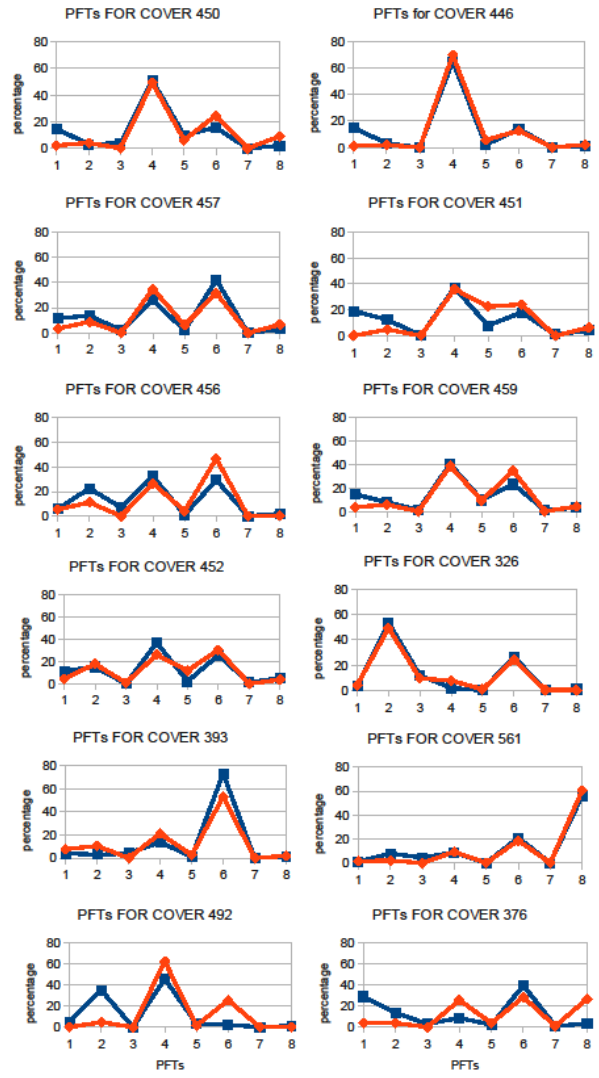
Fig. 12. Comparison between ECOCLIMAP-II and FORMOSAT for the 12 ECOCLIMAP-II covers most frequent in the FOR- Figure 12. Comparison between ECOCLIMAP-II and FORMOSAT for : 2 MOSAT area (y-axis in percentages); blue plots – ECOCLIMAP-II, red plots – FORMOSAT. X-axis – 8 types of surface or PFTs – abscissas: 1/bare soil, 2/decid- uous trees, 3/coniferous trees, 4/C3 crops, 5/C4 + irrigated crops, 6/grasslands, 7/water bodies and 8/urban